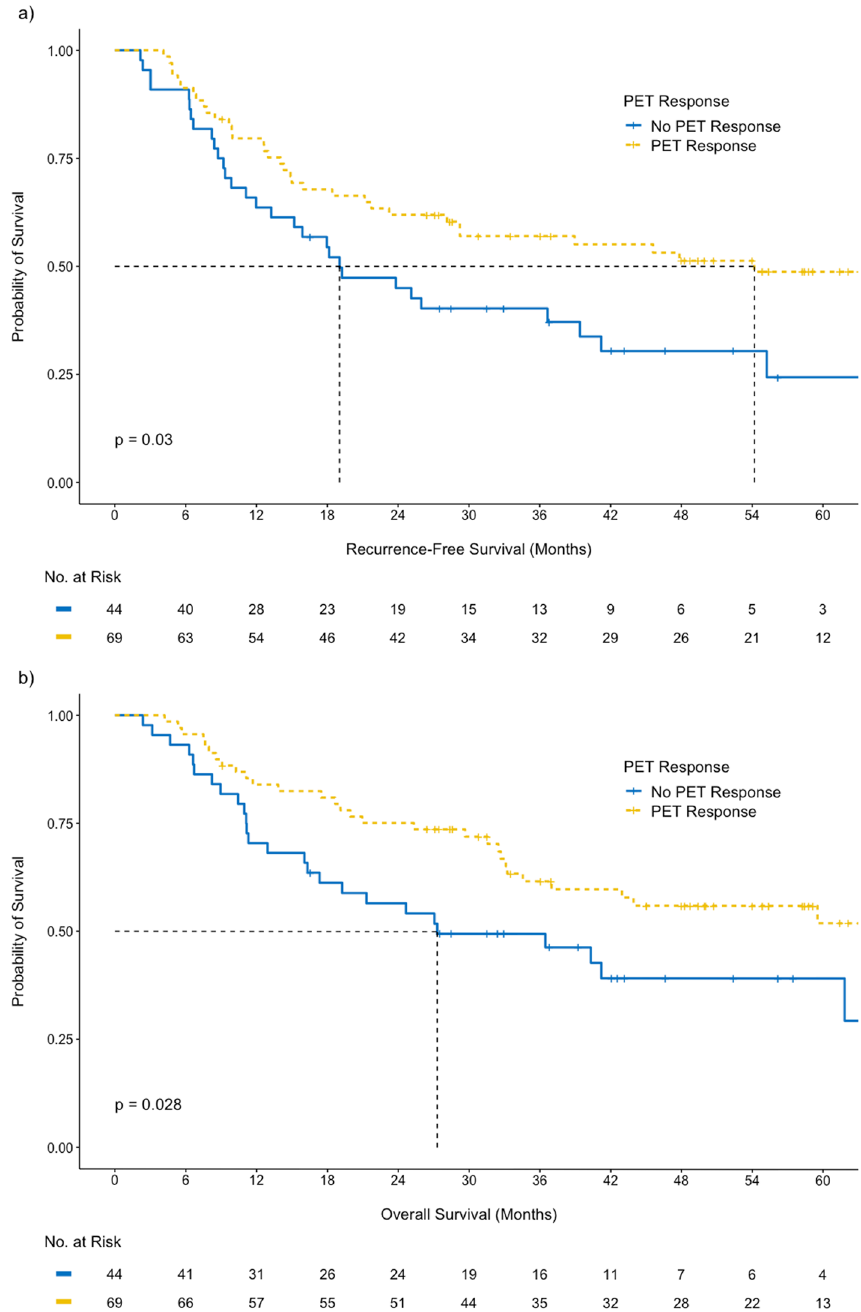
Figure 4. Cumulative ( a ) recurrence-free and ( b ) overall survival depending on PET response status using a 35% SUVmax reduction threshold